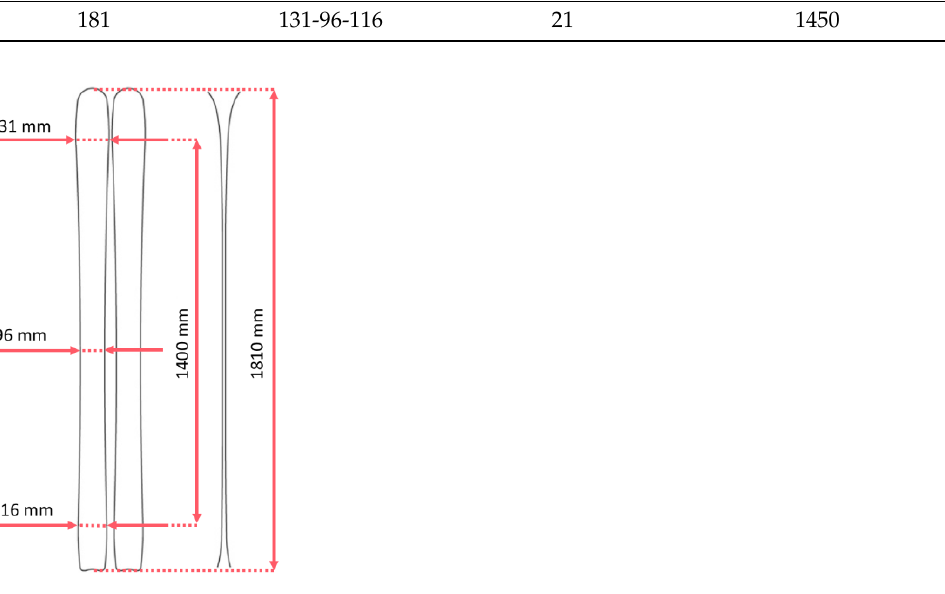
Figure 1. Ski parameters of newly engineered and tested skis.